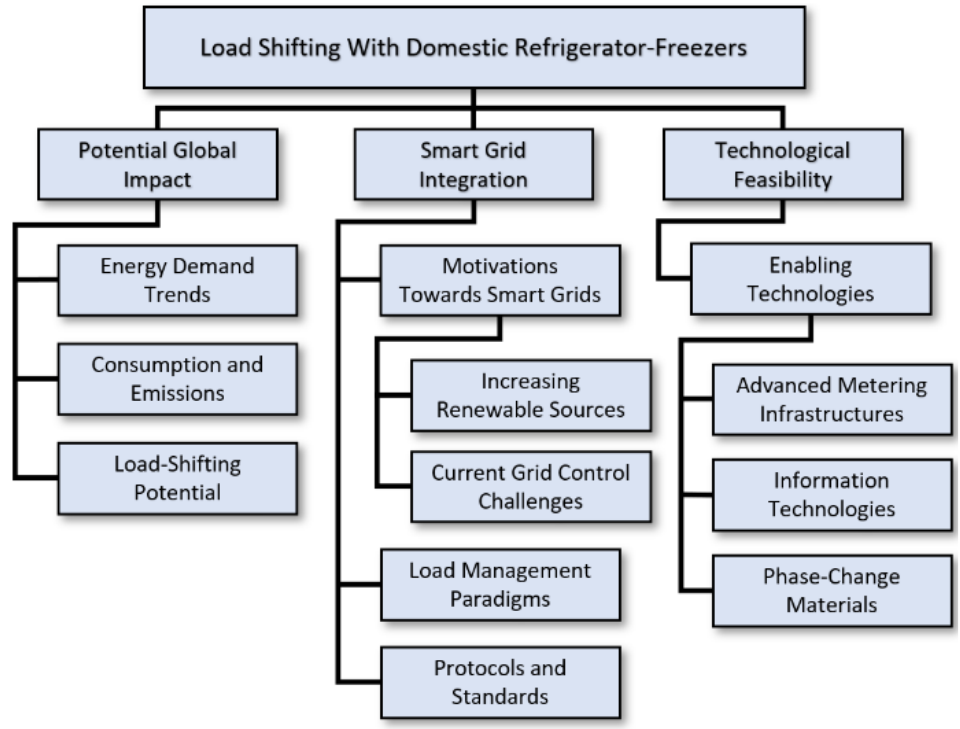
Figure 1. Overview of the subjects covered in the present literature review.